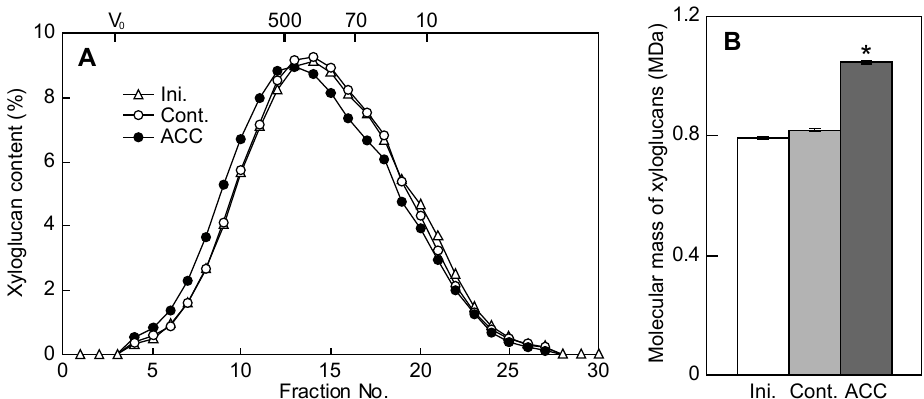
Figure 3. Molecular mass distribution and molecular mass of xyloglucans of ACC-treated azuki bean epicotyls. ACC treatment was carried out in accordance with the parameters shown in Figure 1. The elution profiles of xyloglucans ( A ) on a gel permeation column (TSK-GEL 5000 PW) are shown as the means of three replicates without SE. Vertical bars indicate the elution position of void volume (V 0 ) and molecular mass standards (in kDa). The weight-average molecular mass of xyloglucans ( B ) was determined on the basis of the elution profile of xyloglucans. Values in ( B ) are presented as the means ± SE ( n = 3). * p < 0.05, mean with significant differences between control and ACC treatments.